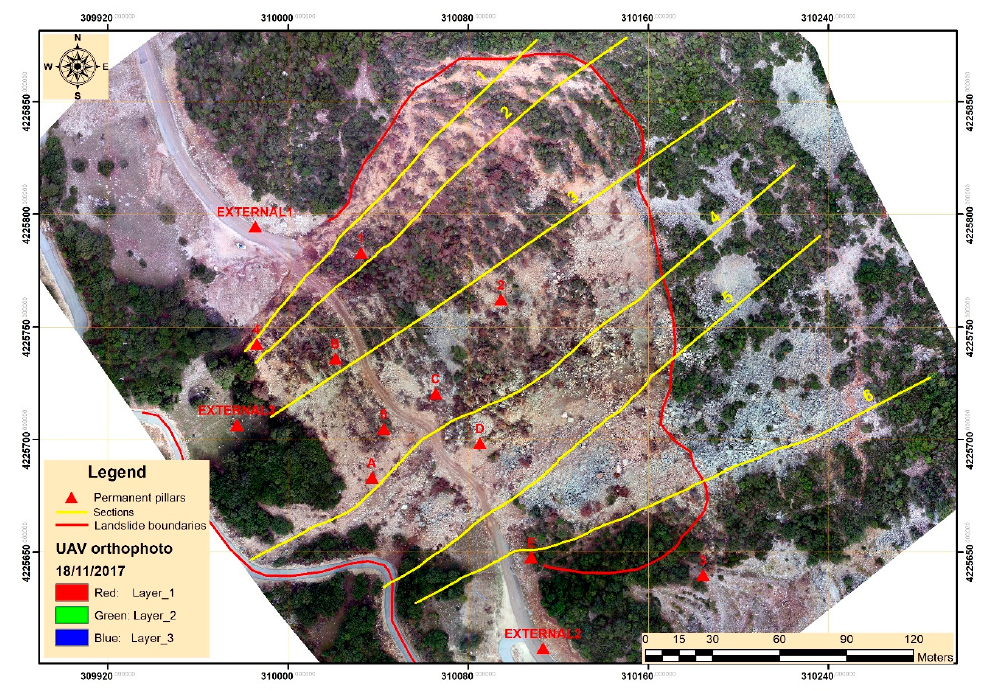
Figure 11. Distribution of sections within the study area. Minerals 2021 , 11 , x FOR PEER REVIEW